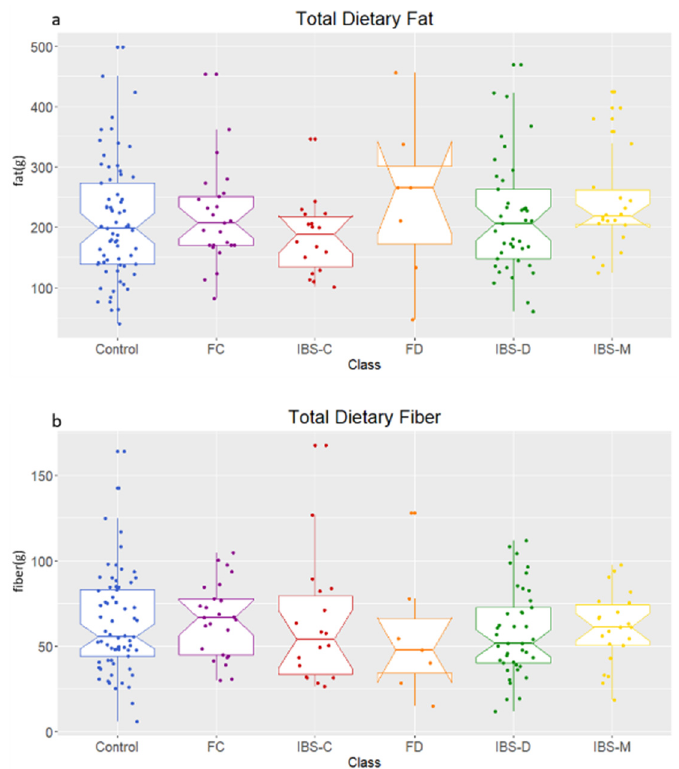
Figure 1. Dietary intake of ( a ) fat and ( b ) fiber over 3-day period recorded using diet diaries for each participant. Healthy control (control), functional constipation (FC), IBS-constipation (IBS-C), func- tional diarrhea (FD), IBS-diarrhea (IBS-D), IBS-mixed (IBS-M). Boxplots show median (center line), 25th and 75th percentile (top and bottom of boxes, respectively), with whiskers representing 1.5 times the inter-quartile range, and boundaries of notches show 95% confidence interval (CI).